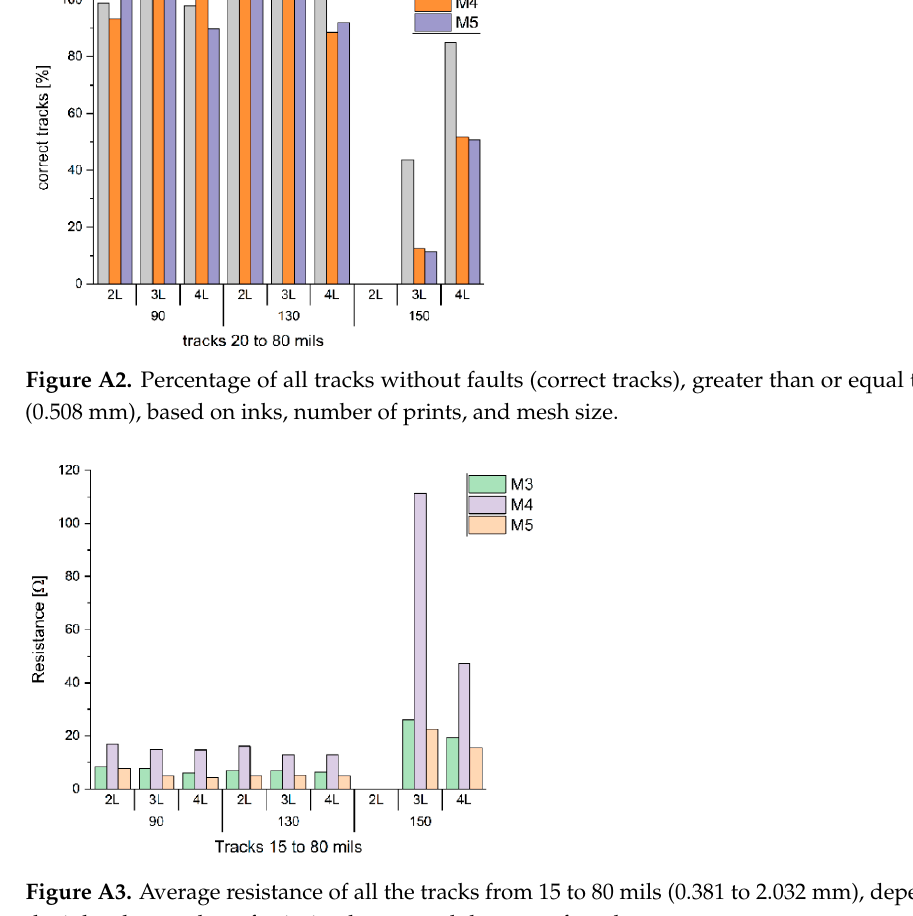
Figure A3. Average resistance of all the tracks from 15 to 80 mils (0.381 to 2.032 mm), depending on the inks, the number of printing layers, and the type of mesh.